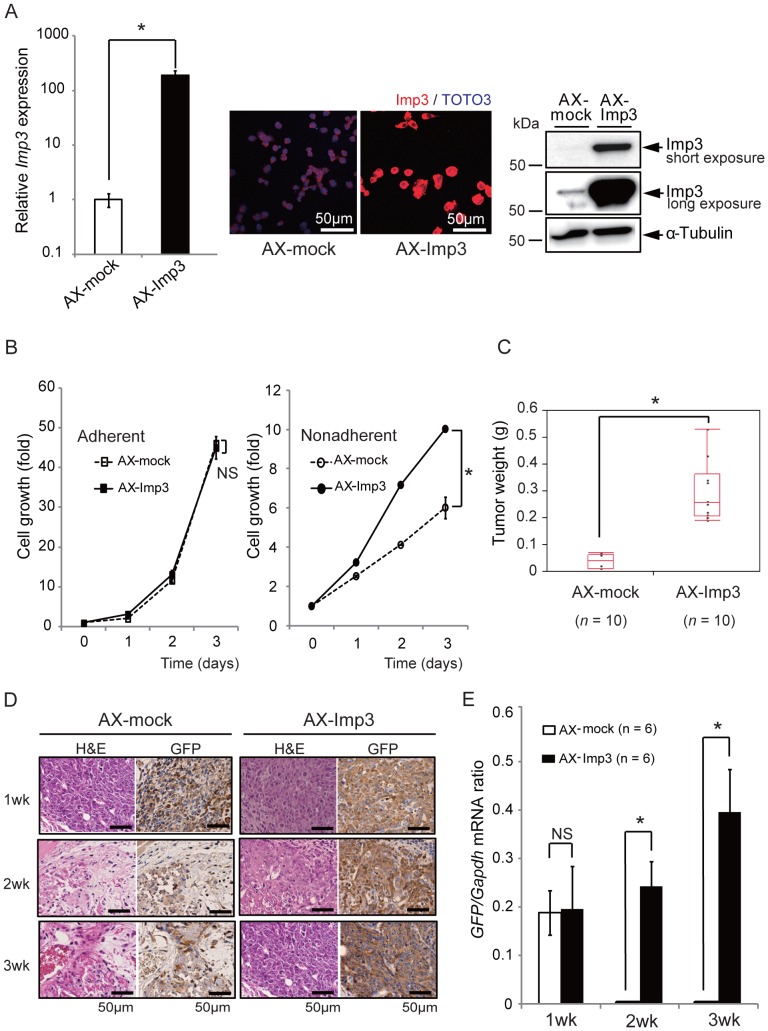
Imp3 overexpression in AX cells promotes cell proliferation and tumorigenic activity.(A) The expression level of Imp3 was evaluated by real-time PCR analyses, immunofluorescence and immunoblotting. *P<0.01. (B) Cell proliferation assays for AX-mock and AX-Imp3 cells cultured under adherent or nonadherent conditions. *P<0.01. NS, not significant. (C) Weight of tumors derived from subcutaneously injected AX-mock or AX-Imp3 cells. *P<0.001. (D, E) Tumors formed at 1, 2, or 3 weeks after subcutaneous injection of AX-mock or AX-Imp3 cells in mice were subjected to H&E staining and to immunohistochemical staining for GFP in serial sections as well as to real-time PCR analysis of GFP. *P<0.01. NS, not significant.